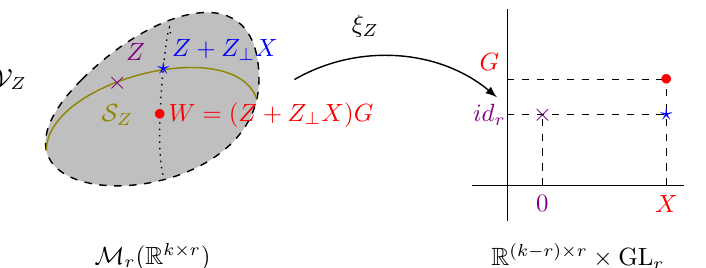
Figure 1. Illustration of the chart ξ Z which associates to W = ( Z + Z the parameters ( X , G ) in R ( k − r ) × r